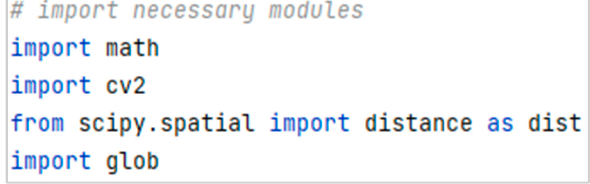
Figure 4. Importing necessary modules.